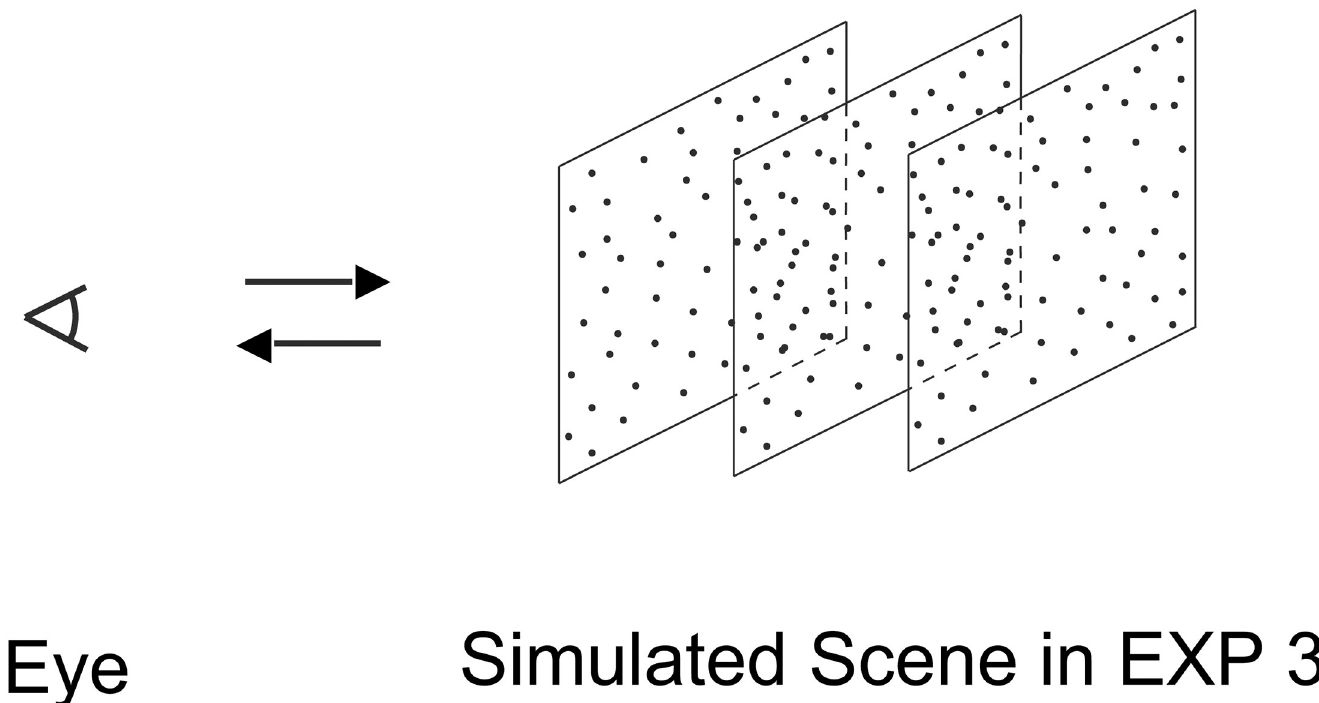
Fig 6. Schematic representation of the simulated scene in Experiment 3, which mimicked the effects of an observer’s motion towards or away from three transparent frontoparallel surfaces covered with random dots. Experiments 1, 2, 4 & 5 mimicked an observer’s smooth motion towards or away from a single frontoparallel surface. The single frontoparallel surface was located at a distance from the observer’s eye equal to the middle surface in this figure for Experiments 1, 2 & 5 and equal to the left surface in this figure for Experiment 4, respectively. The average dot density on the single frontoparallel surface was three times of and equal to that on a surface in this figure for Experiments 1, 2 & 4 and Experiment 5,